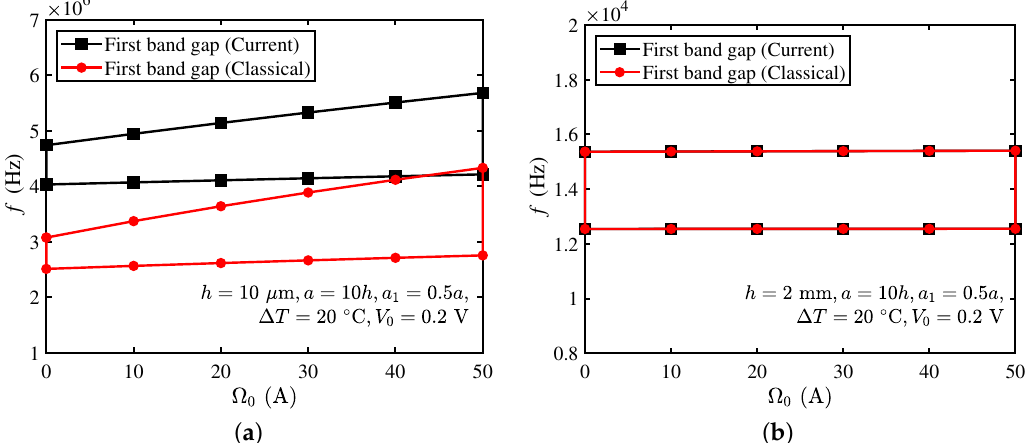
Figure 8. Bandgaps of current and classical models under different external magnetic potentials with ( a ) h = 10 µ m, and ( b ) h = 2